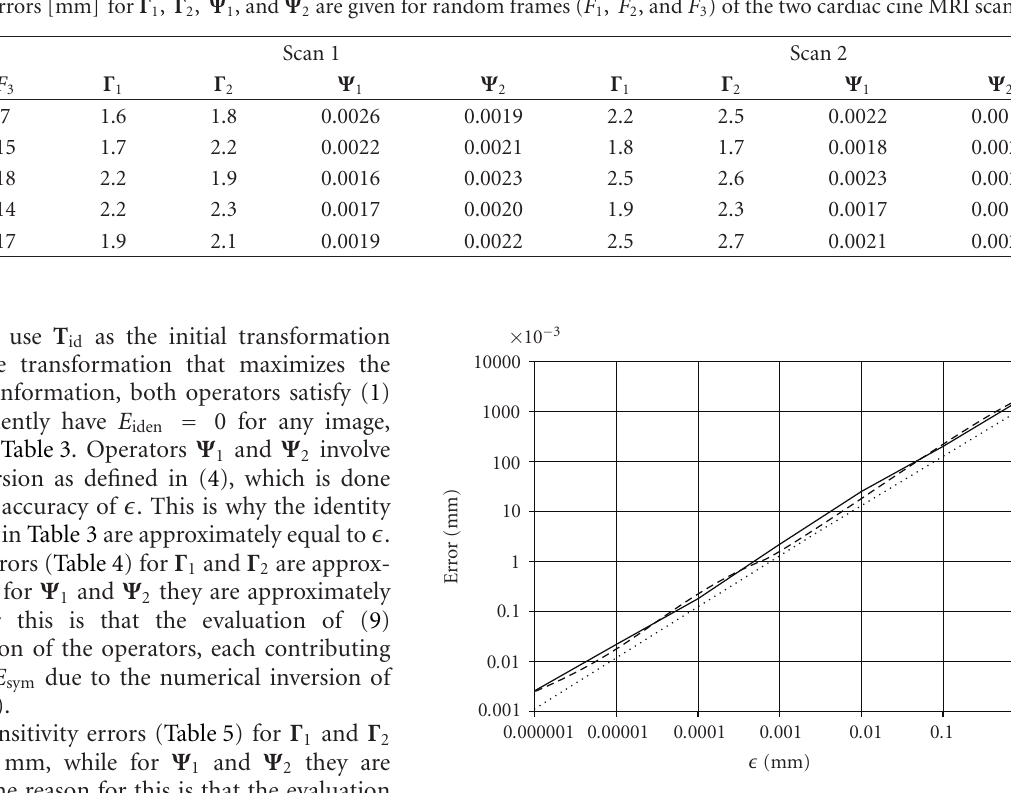
Figure 4: The dependence of E iden (dotted), E sym (solid), and E tran (dashed) on (cid:2) for Ψ 1 is shown in the log-log axes for a representative image, image pair, and image triple, respectively. The three curves represent interpolations of the errors corresponding to (cid:2) of 0.000001 mm, 0.00001 mm, 0.0001 mm, 0.001 mm, 0.01 mm, 0.1 mm, and 1.0mm. The squared correlation coe ffi cient between E iden and (cid:2) is .9998, between E sym and (cid:2) is .99997, and between E tran and (cid:2) is .9998, indicating a strong dependence of the three errors on (cid:2)